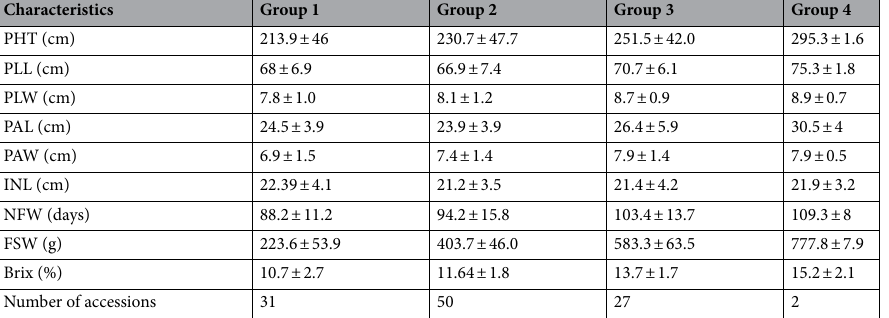
Table 7. Comparison of agro-morphological and phenotypic traits of four groups of Chadian sweet sorghum derived from Ward’s hierarchical clustering. PHT: plant height; PLL: perultimate leaf length; PLW: perultimate leaf width; PAL: panicle length; PAW: panicle width; INL: internode length; NFW: number of days to flowering; FSW: fresh stalk weight. ± standard